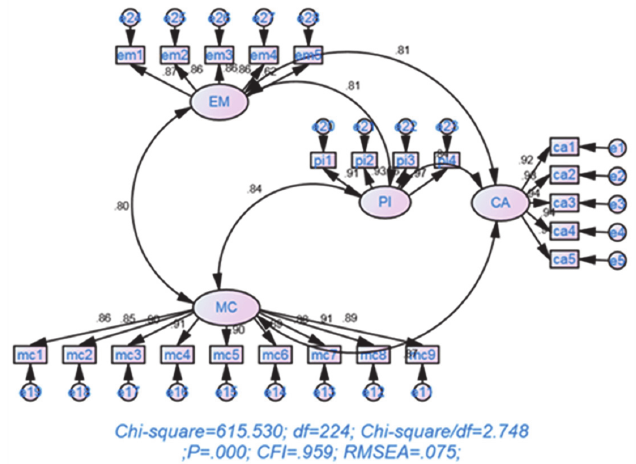
Fig. 2. Results from